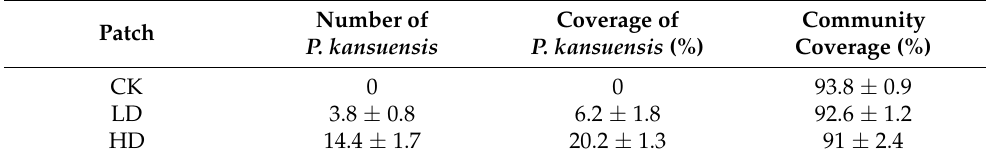
Table 1. Selection of P. kansuensis under different densities.